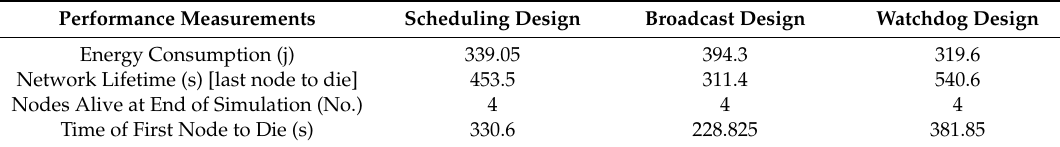
Table 10. Results summary.